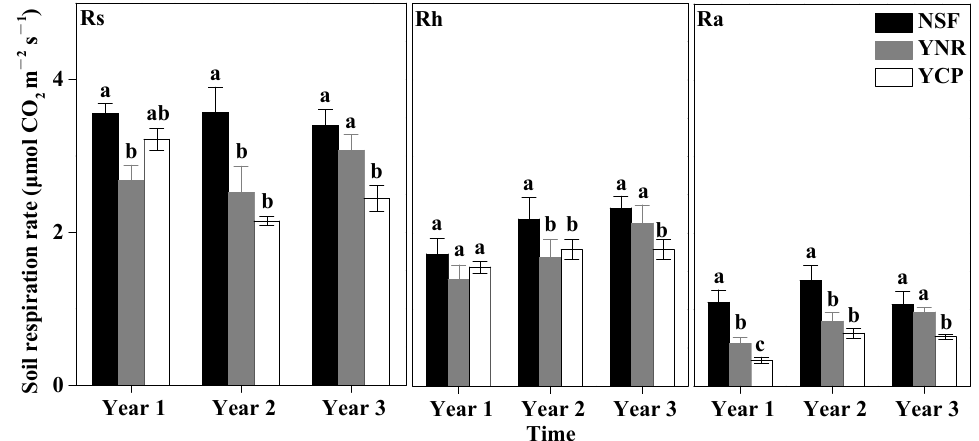
Figure 3. Mean (±standard deviation) soil respiration (Rs), heterotrophic respiration (Rh), and autotrophic respiration (Ra) rates in the first three years following a reforestation experiment in a mature natural secondary forest (NSF), a young forest established through assisted natural regeneration (YNR), and a young Castanopsis carlesii plantation (YCP). For the first year, only data of the second half of the year were used to account for transient effects caused by the decomposition of dead roots. Different letters indicate significant different between forests at p < 0.05. For a given period of a give respiration rate (Rs, Rh, or Ra), forests sharing no common letters are significantly different at p <